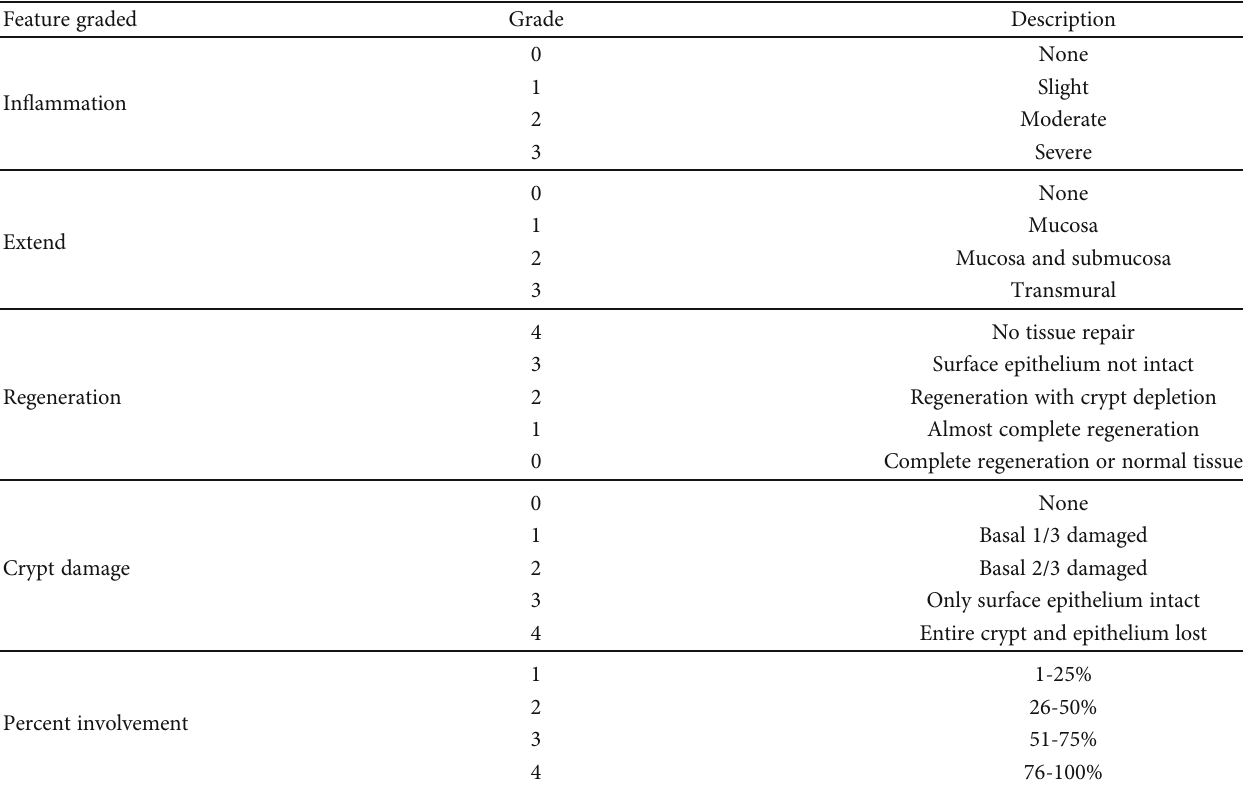
Table 3: Histological grading of